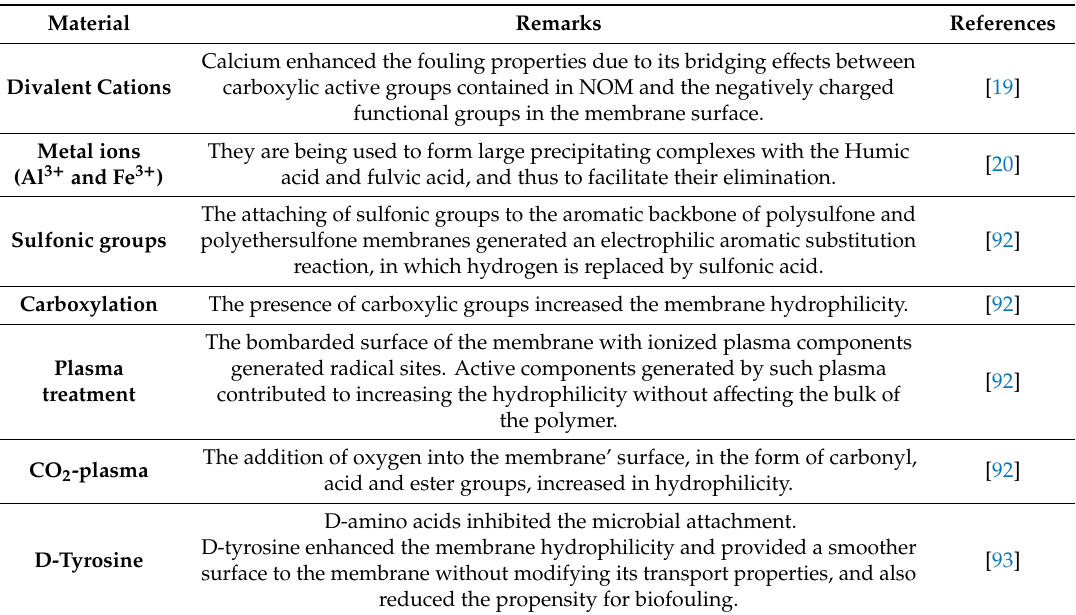
Table 5. Chemicals used for chemical modification of membrane’s